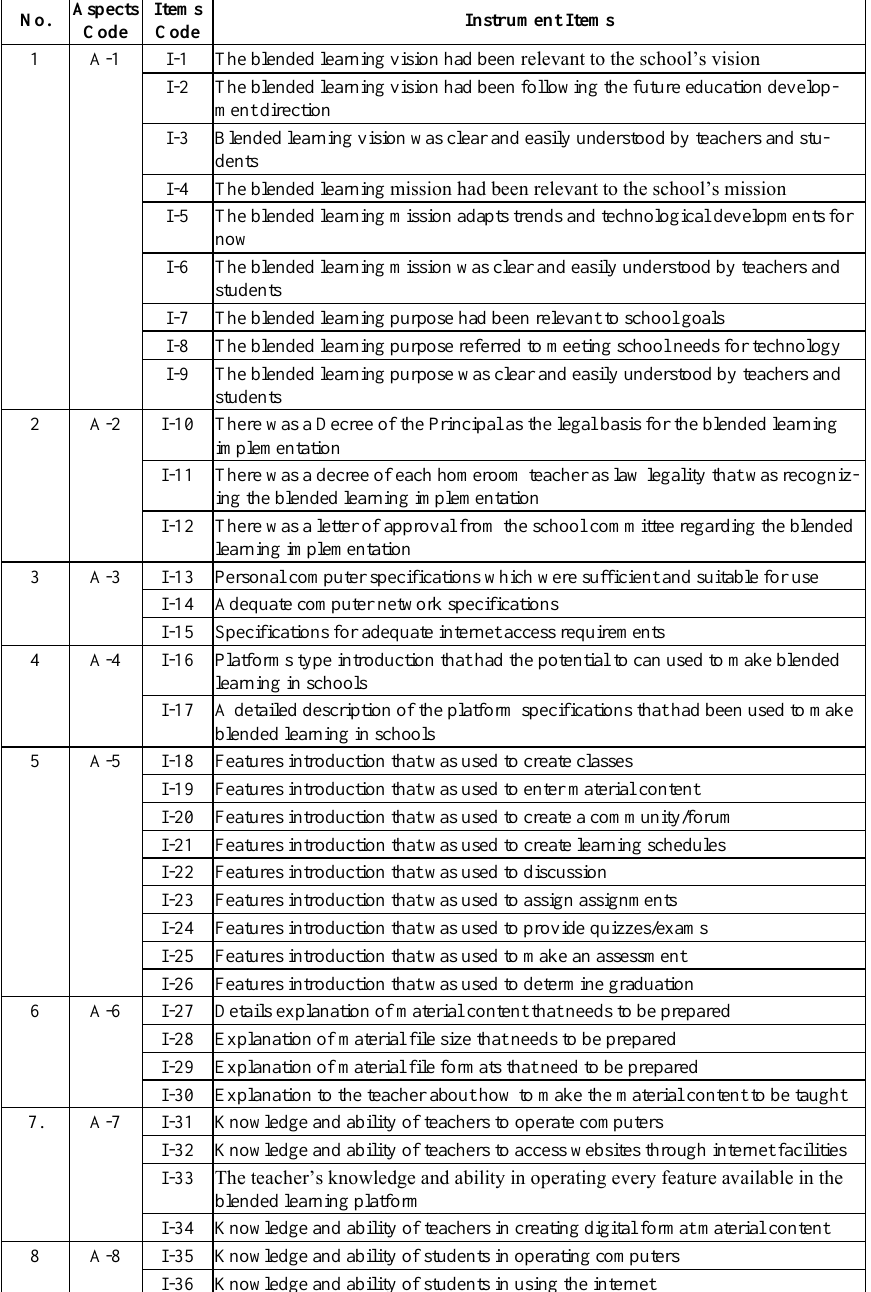
Table 4. The Tri Kaya Parisudha-based Countenance Evaluation Model Instrument Items Aspects No.